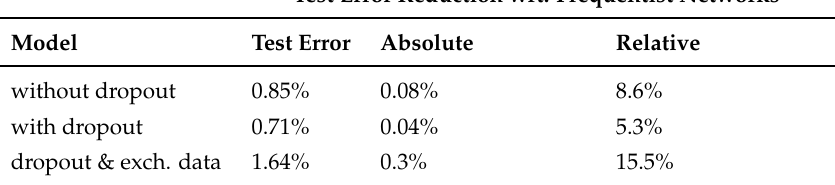
Table 2. Accuracies Bayesian